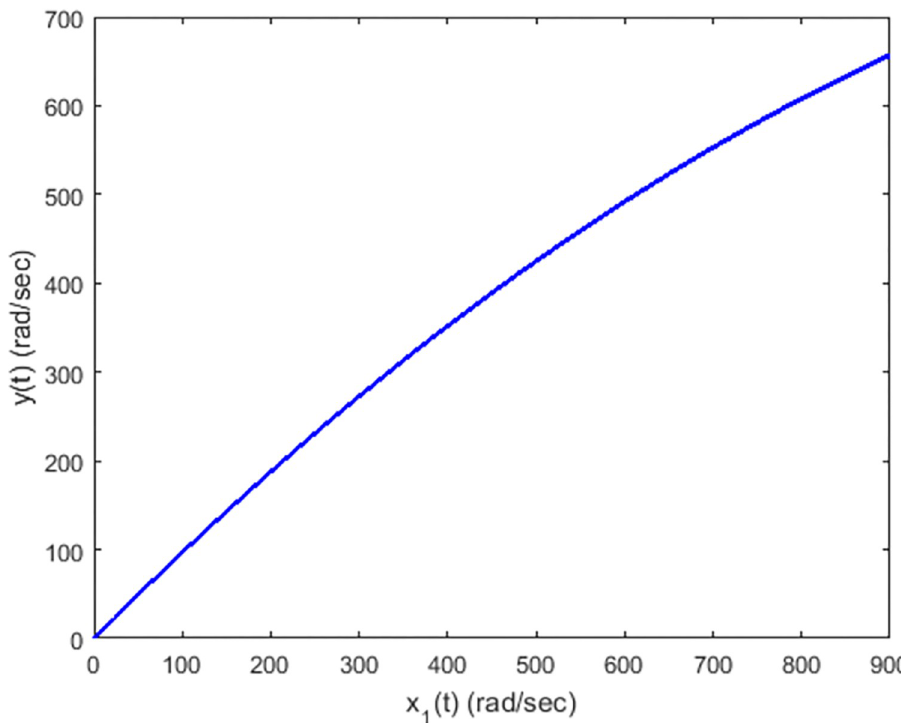
Fig 8. Sensor nonlinearity for DC motor speed control.